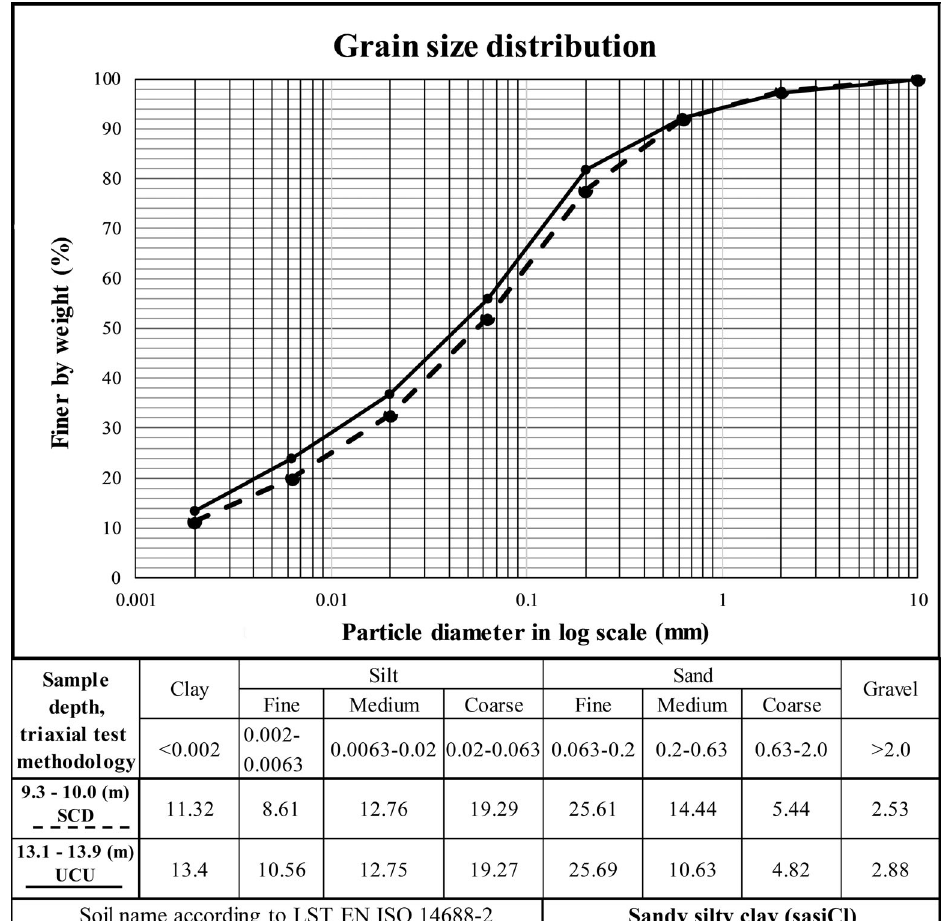
Fig. 5. Grain size distribution